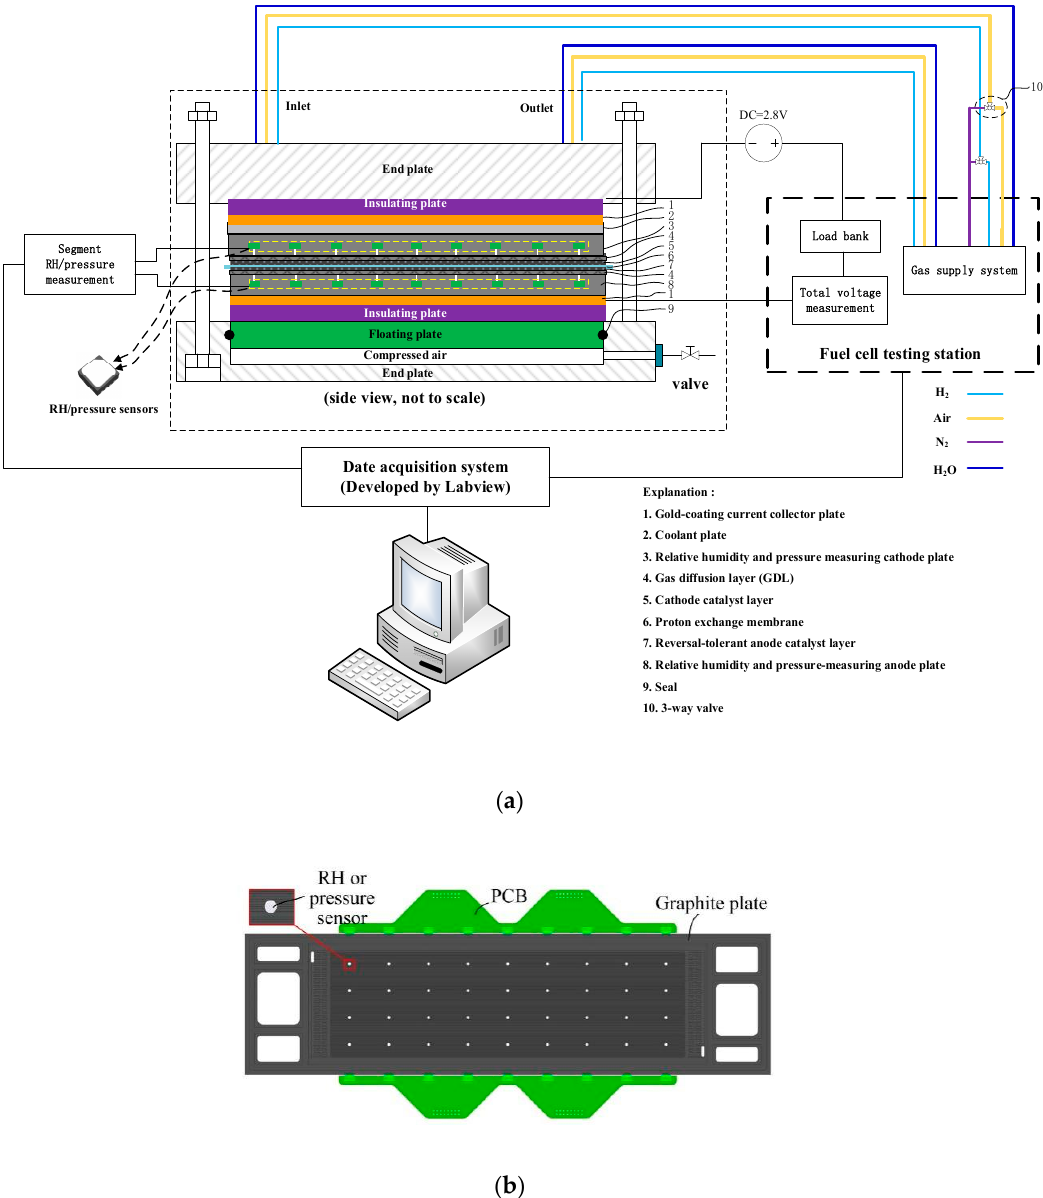
Figure 2. Segmented testing schematic on a bipolar plate. ( a ) segmented testing platform. ( b ) segmented zones on a bipolar plate.